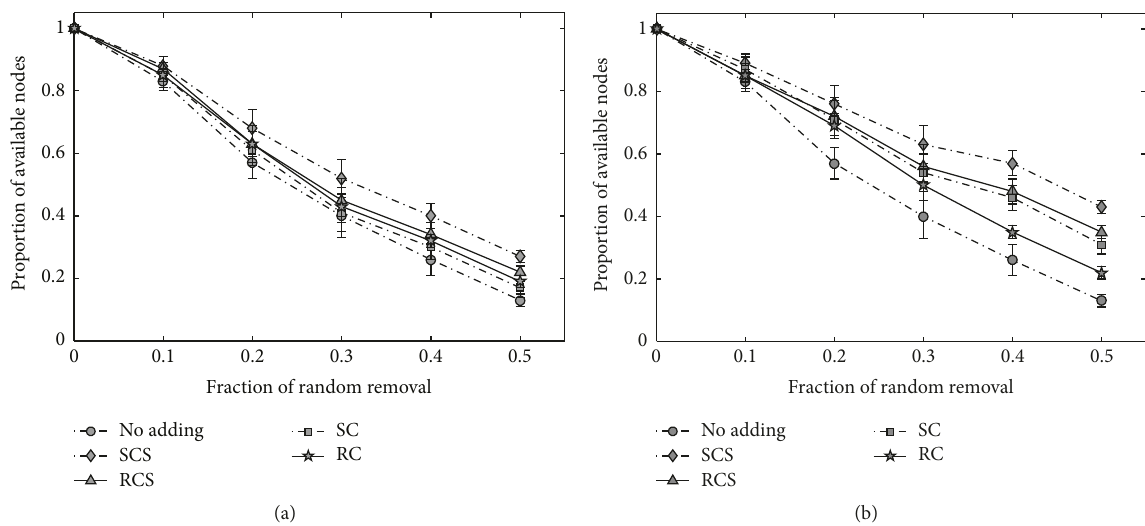
Figure 8: Error tolerance of the network with 𝑞 = 0.01 and 𝑞 = 0.1 . (a) 𝑞 = 0.01 . (b) 𝑞 = 0.1